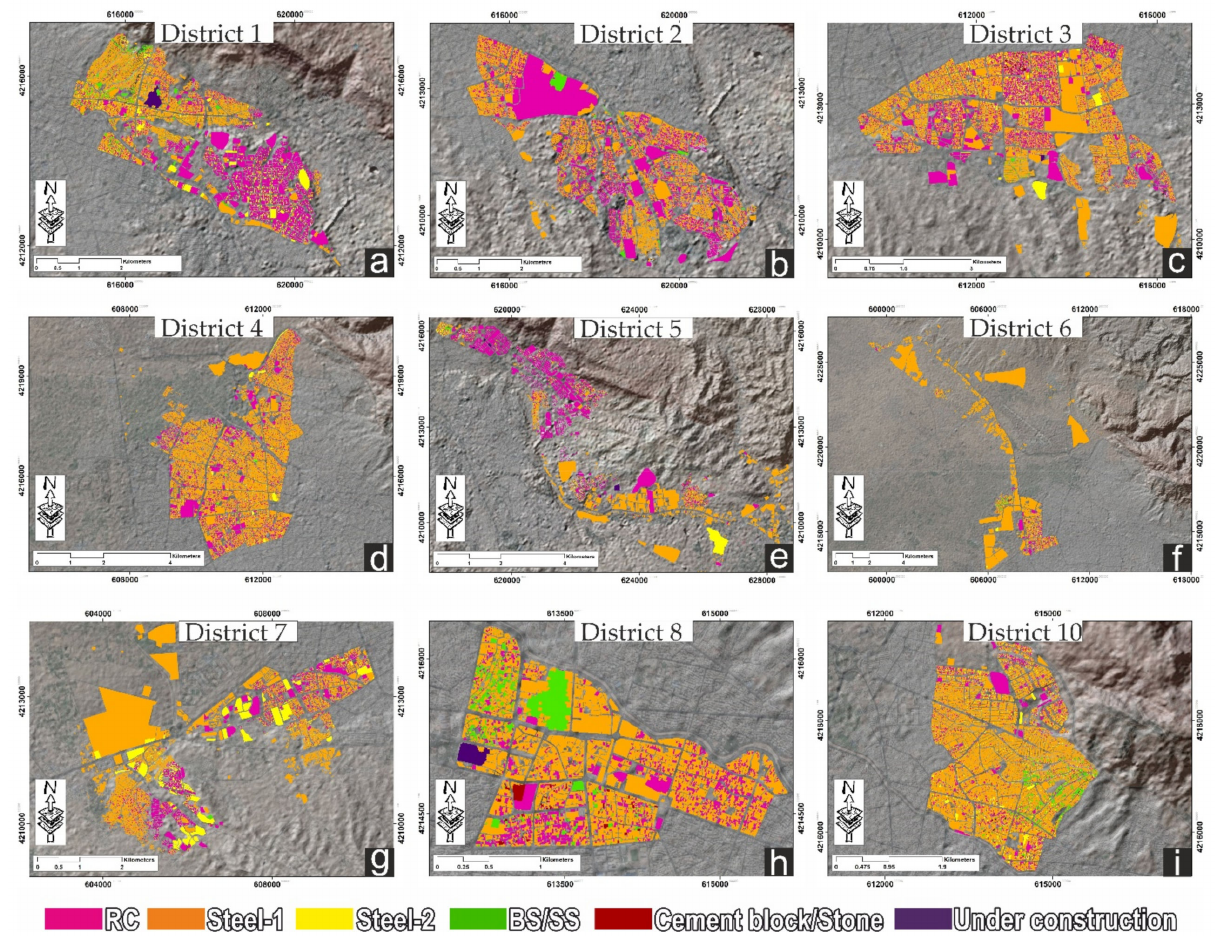
Figure 16. Status of the structural dispersion in the Tabriz municipality areas. ( a ) district 1; ( b ) district 2; ( c ) district 3; ( d ) district 4; ( e ) district 5; ( f ) district 6; ( g ) district 7; ( h ) district 8; ( i ) district